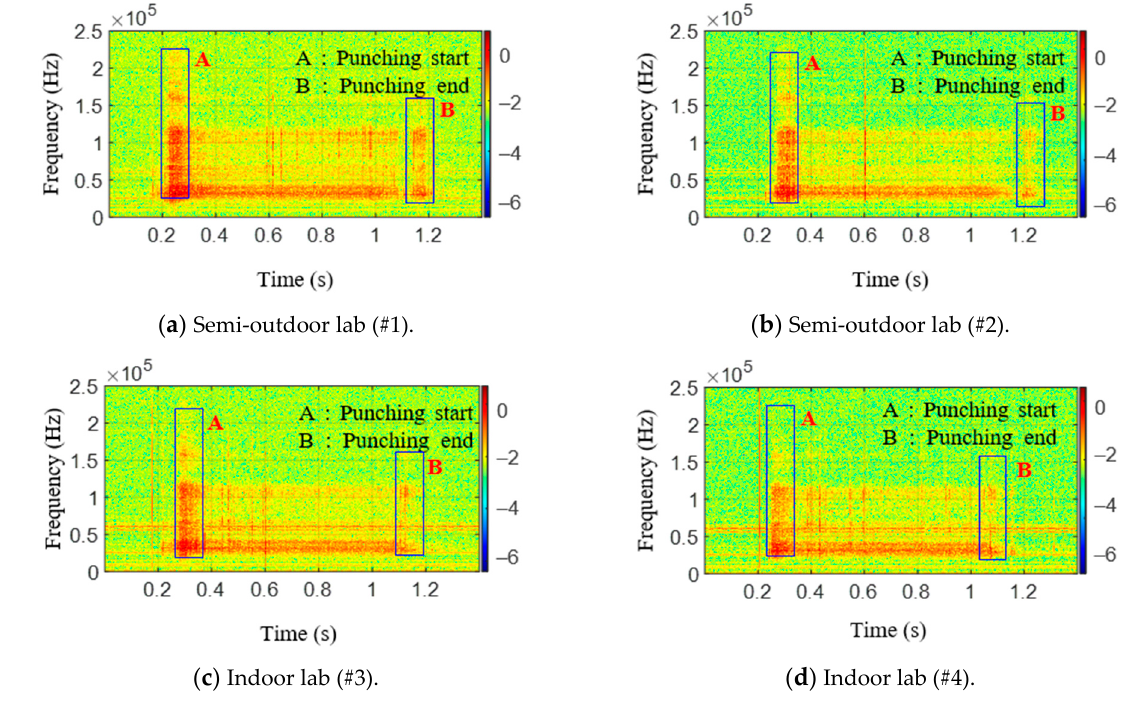
Figure 15. Result of STFT using AE filtered data. Table 4. AE parameters from filtered data.